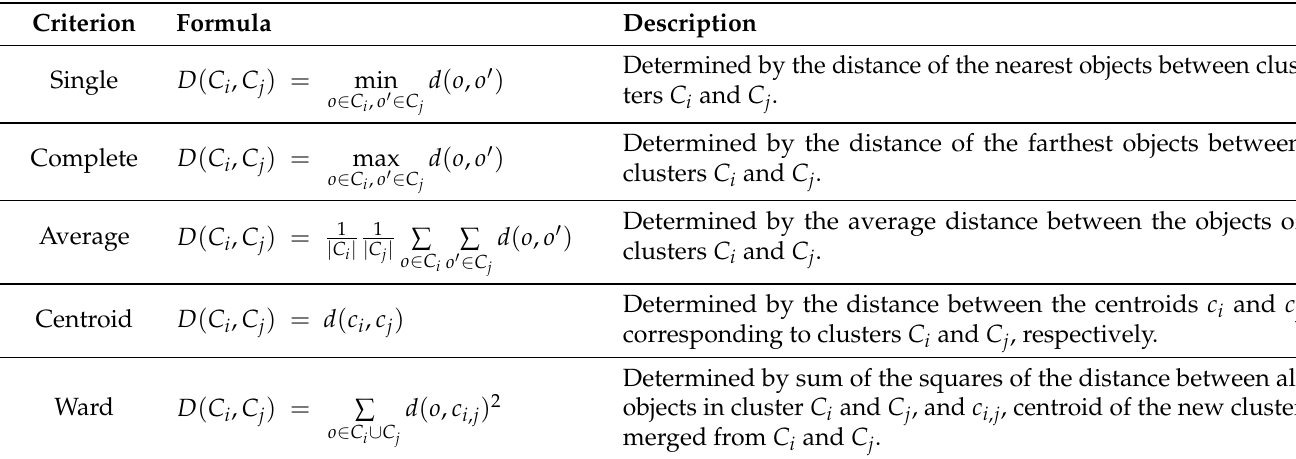
Table 2. Proposed linkage criteria for use in the hierarchical